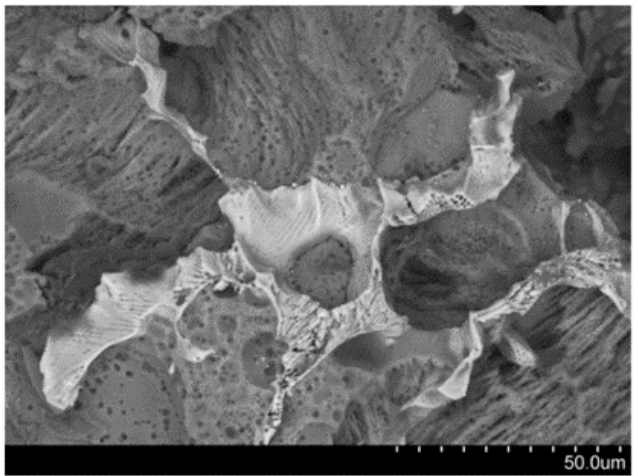
Figure 12. SEM image of the eutectic region on the surface of as-cast WE43 alloy after corrosion.